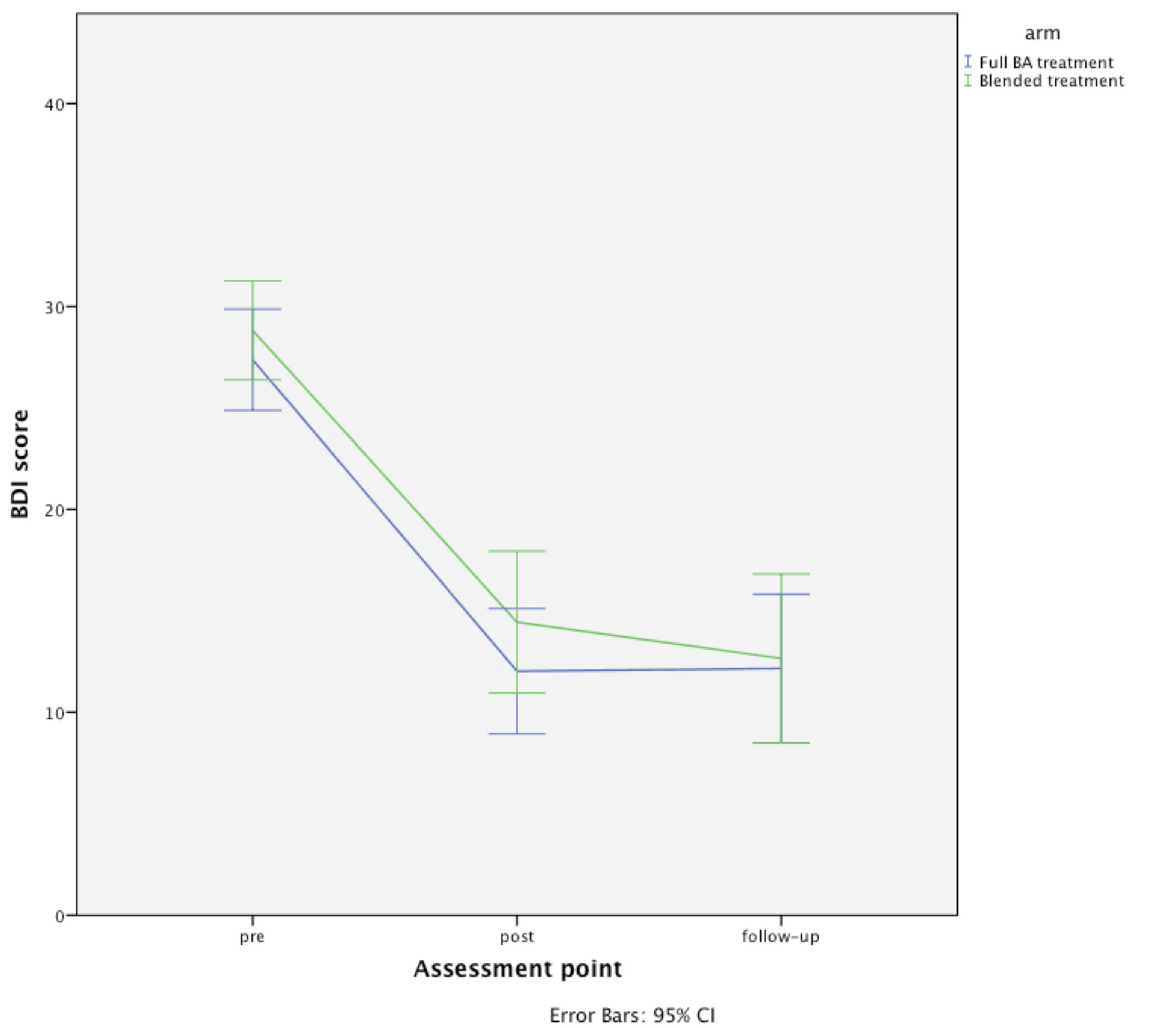
Fig 4. Assessment of the Beck Depression Inventory-II, BDI-II (including 95% confidence